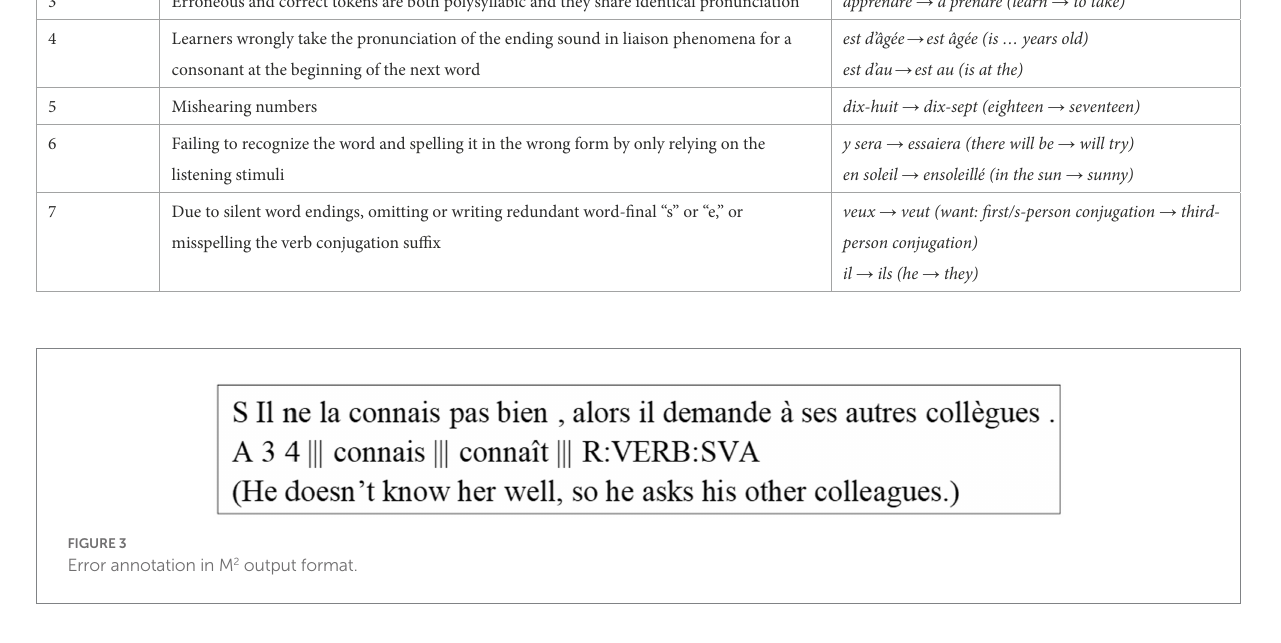
FIGURE 3 Error annotation in M 2 output